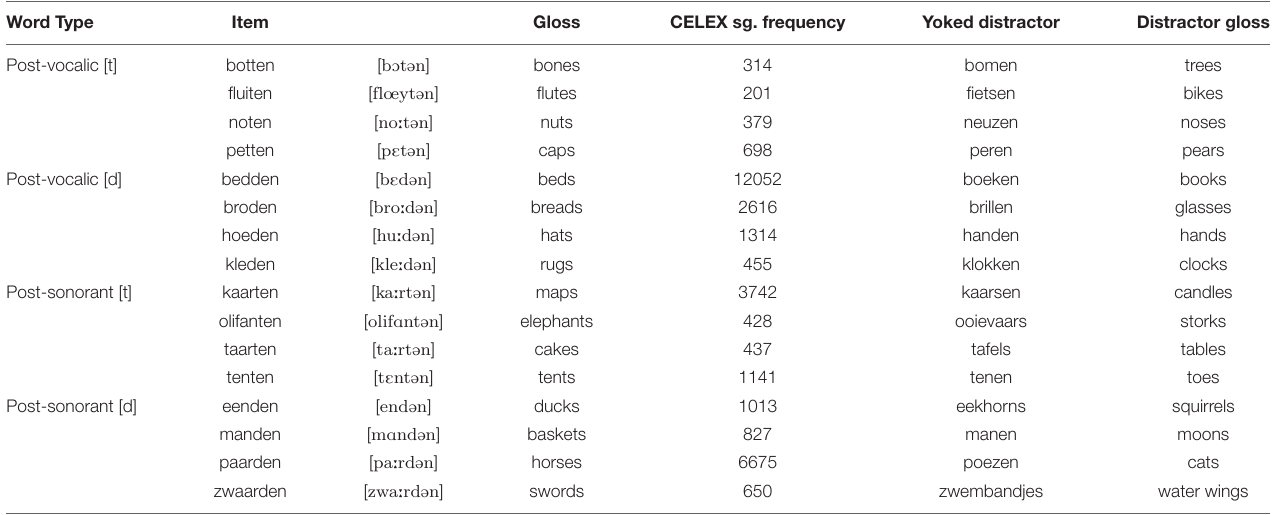
TABLE 3 | Target items used in Experiment